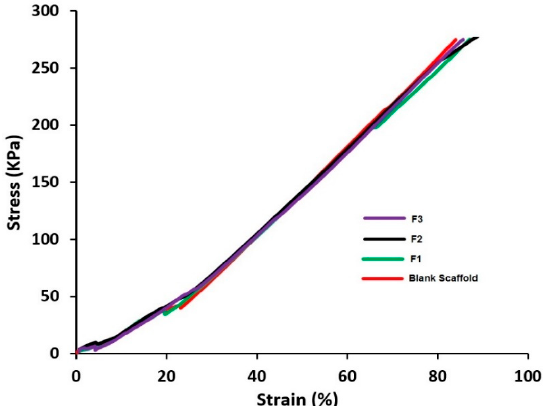
Figure 8. Stress–strain curve of blank scaffold (uncoated) and coated scaffolds: F1 (coated with 5-FU), F2 (coated with 5-FU and Soluplus, F3 (coated with 5-FU, Soluplus and PEG 6000).